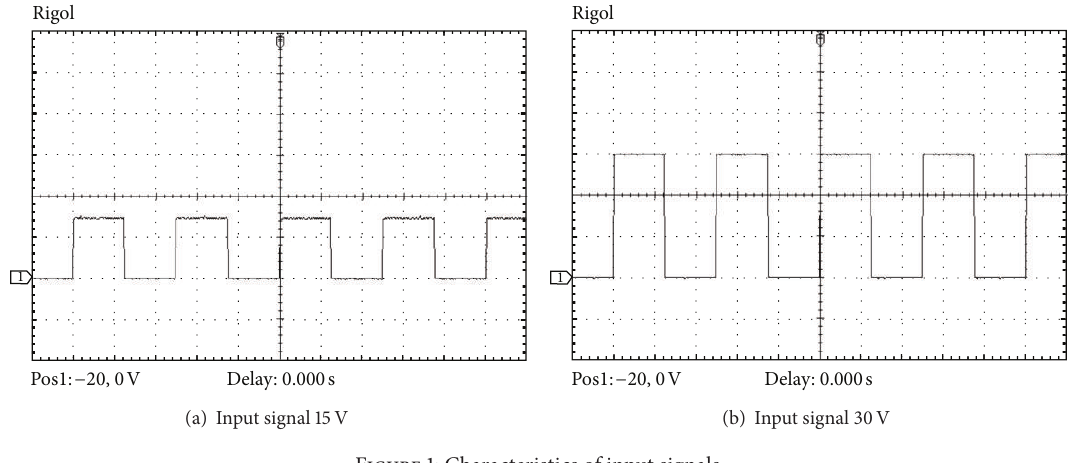
Figure 1: Characteristics of input signals.